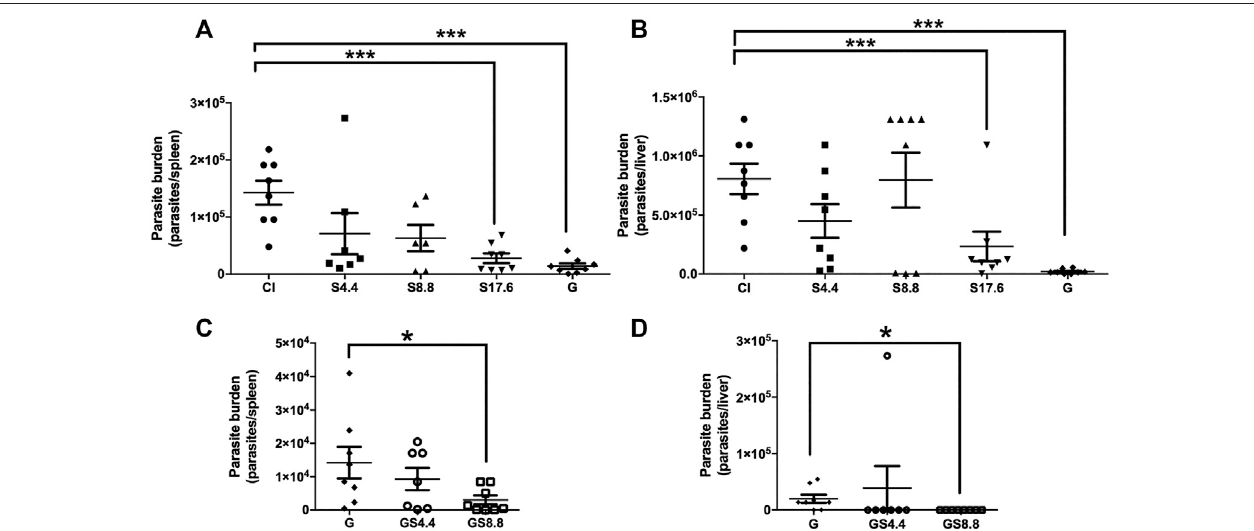
FIGURE 3 | Ef fi cacy of oral spironolactone alone (A,B) and its association with meglumine antimoniate (C,D) in Experimental Visceral Leishmaniasis. BALB/c mice (8 per group) were infected intraperitoneally with 1.0 × 10 8 promastigotes of stationary phase L. infantum . Seven days after infection, the animals were treated with spironolactone in three different doses of 4.4, 8.8, and 17.6 mg/kg/day along with meglumine antimoniate (28 mg/kg/day of Sb 5+ ) by intraperitoneal route. The control group wastreatedwiththevehicle viaanoralroute (PBScontaining2%DMSO).Regardingtheassociationbetweenspironolactoneandmeglumine antimoniate, a fi xed dose of meglumine antimoniate (28 mg/kg/day of Sb 5+ ) was used with 4.4 or 8.8 mg/kg/day of spironolactone. After 23 days of treatment, the animals were euthanized in a CO 2 chamber, and the spleen (panels A and C ) and liver (panels B and D ) were aseptically removed, weighed, and homogenized. The parasite load was estimated using the limiting dilution assay. Data are presented as means ± standard error of 8 animals per group; * p < 0.05 and *** p < 0.001; CI: control infected; S: spironolactone; and G: meglumine